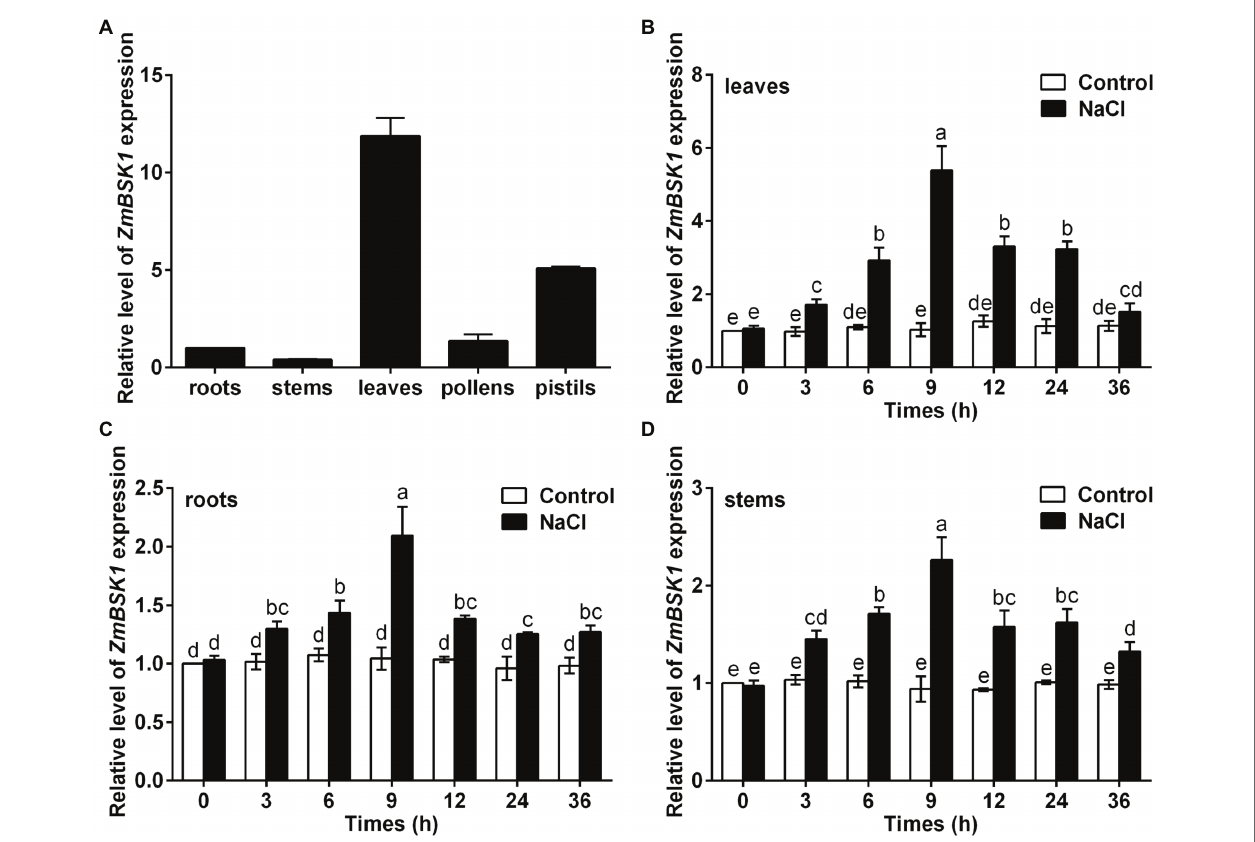
FIGURE 1 | Expression patterns of ZmBSK1 gene in maize. (A) qRT-PCR analysis of the expression levels of ZmBSK1 in different maize tissues (roots, stems, leaves, pollens, and pistils). (B-D) The expression levels of ZmBSK1 in maize leaves (B) , roots (C) , and stems (D) exposed to salt stress. About 10-day-old wild type seedlings were treated with 200 mM NaCl for indicated times, and the expression was measured by qRT-PCR. ZmActin2 served as an internal control. Error bars represent ±SD ( n = 3). Different letters indicate significant differences at p < 0.05 according to two-way ANOVA (Duncan’s multiple range